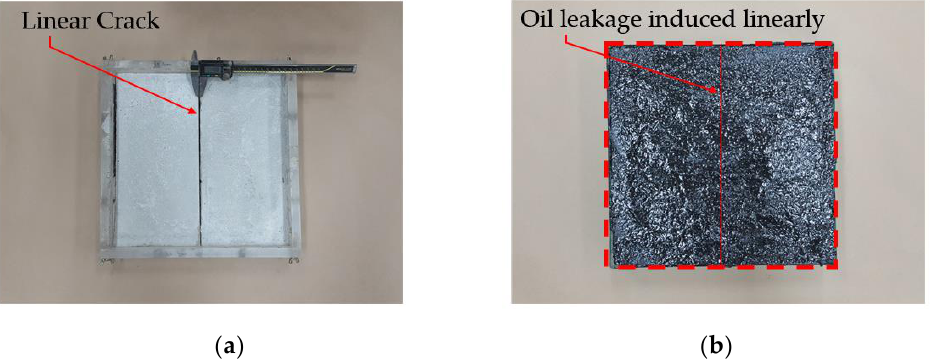
Figure 1. Previous ENC-SPRG evaluation specimen structure; ( a ) linear crack specimen, ( b ) limited observation of oil leakage.